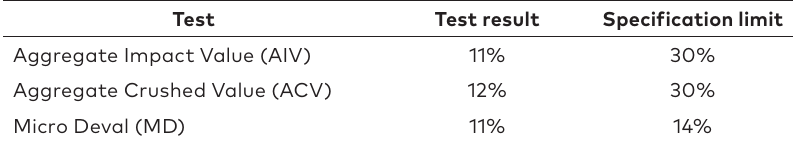
Table 1. Physical properties of